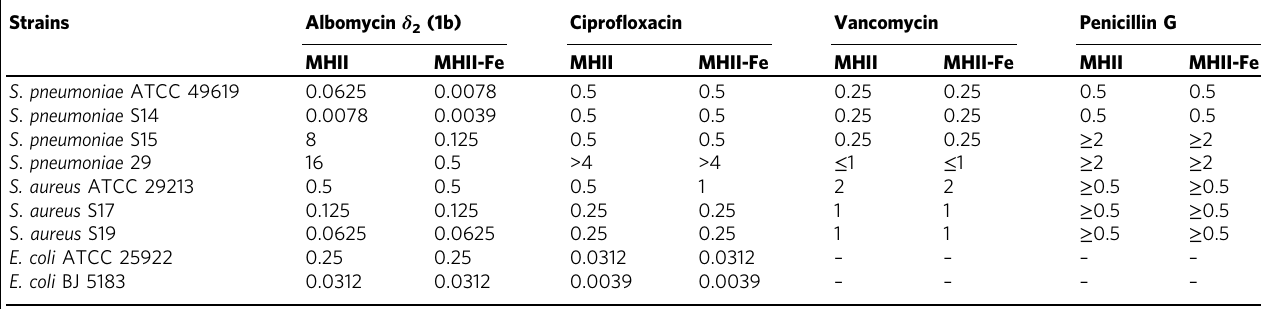
Table 3 MIC values ( μ g/mL) of albomycin δ 2 (1b) against S. pneumoniae, S. aureus and E. coli strains in MHII and MHII-Fe